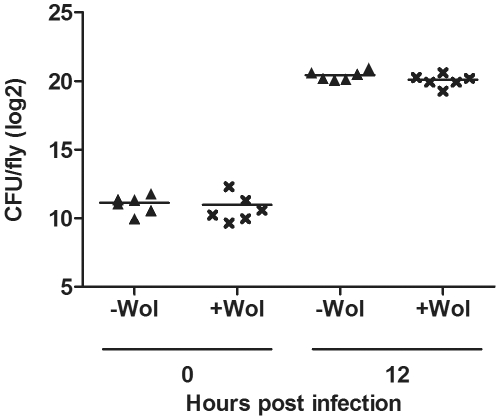

In vivo bacterial growth of P. aeruginosa PA01 D. melanogaster ORC adults with and without Wolbachia infection.Graph shows the number of bacteria per fly (CFU/fly) of P. aeruginosa PA01 in D. melanogaster without (triangle) and with wMelCS (cross) at time 0 and 12 hours post infection.